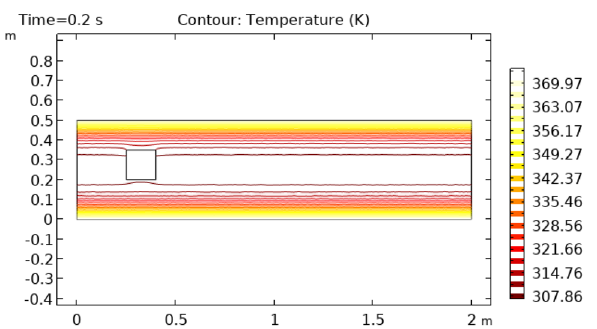
Figure 14. Contour temperature in squared cylindrical flow at t = 2